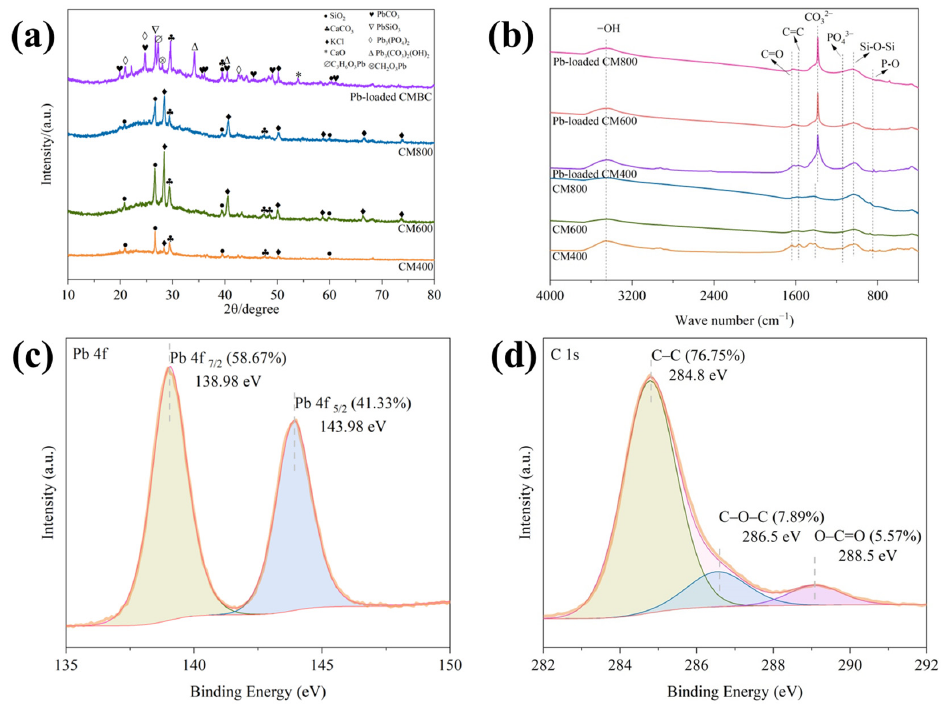
Figure 7. XRD, FTIR and XPS spectra of Pb(II)–loaded (( a ): XRD spectrum, ( b ): FTIR spectrum, ( c ) and ( d ): XPS spectra). ( c , d ): XPS